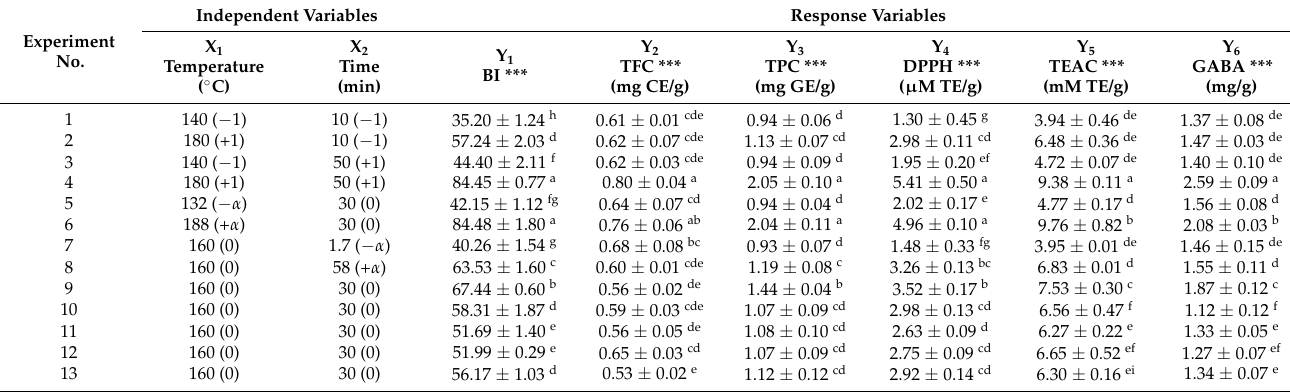
Table 3. Experimental design used to CCD and experimental results of responses